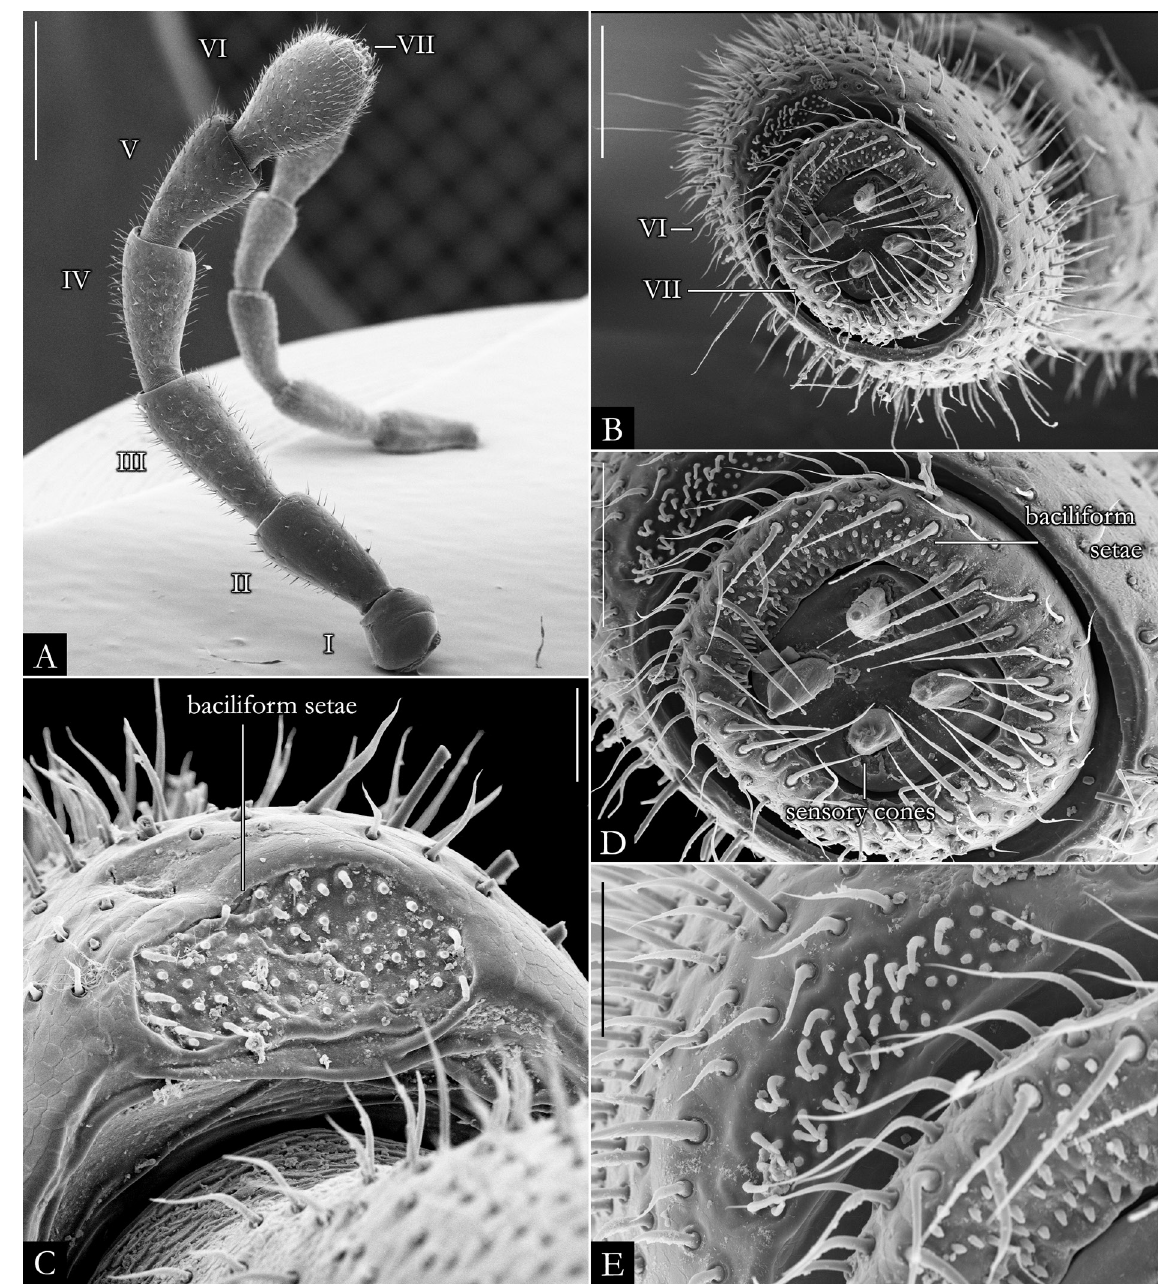
Fig. 21. SEM images of antennae. A . Antenna of female of Pseudonannolene halophila Schubart, 1949 (IBSP 1101). B . Apical view of antenna of female of P. robsoni Iniesta & Ferreira, 2014 (IBSP 3506). C . Detail of antennomere V of male of P. robsoni (IBSP 3526). D . Detail in apical view of antennomere VII of female of P. robsoni (IBSP 3506). E . Detail of antennomere VI of female of P. robsoni (IBSP 3506). Scale bars: A = 1 mm; B = 0.15 mm; C, E = 0.05 mm; D = 0.1